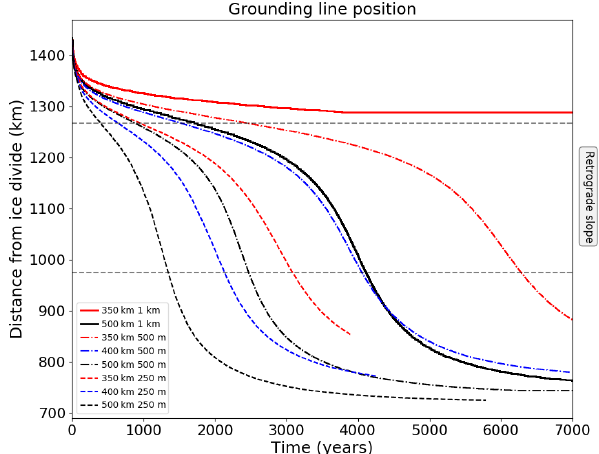
Figure A2. Grounding line retreat for the mesh resolution depen- dence experiments using the Weertman sliding relation. Buttressing parameters of 350, 400 and 500km are used with 1km, 500m and 250m uniform element size in the